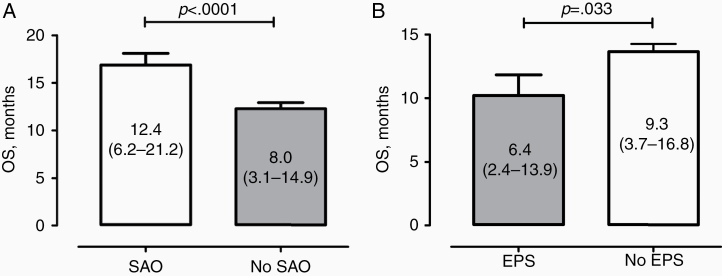
OS (median values including the interquartile range in parentheses) of the patients in the cohort depending on the occurrence of SAO (A) or EPS (B) in the perioperative course.